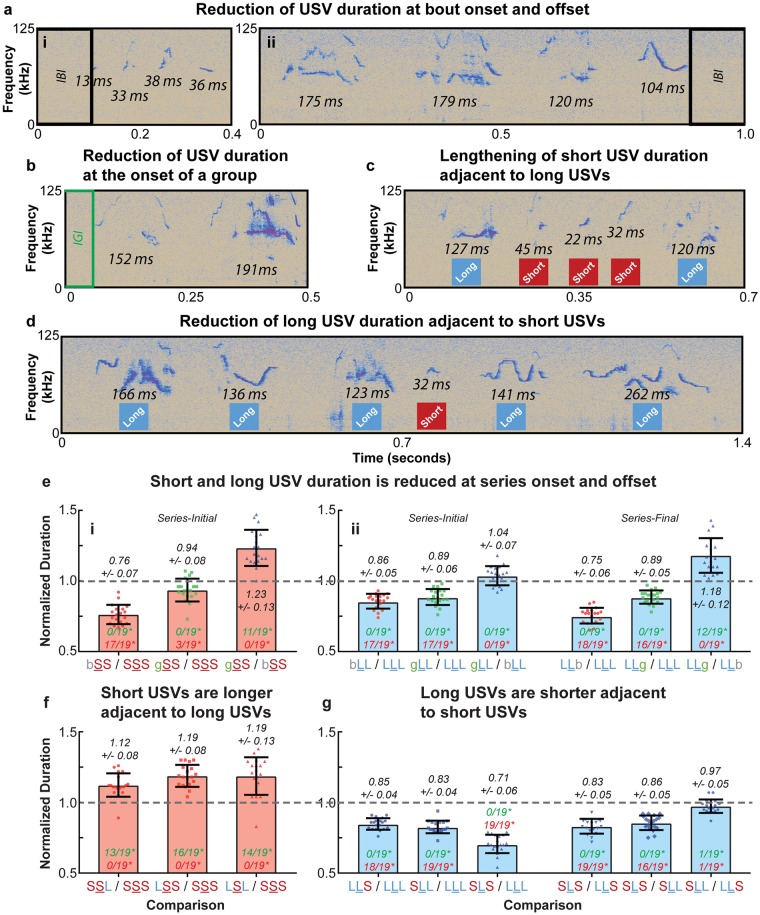
USV series exhibit consistent fine-scale temporal structure.(a) Example spectrogram from an adult male mouse showing reduction of USV duration (a.i) bout-initially (a.ii) bout-finally. (b) Example spectrogram from an adult mouse depicting reduction of long USV duration group-initially. Example spectrograms of USVs produced by an adult mouse demonstrating (c) the reduction of long USV duration adjacent to a short USV, and (d) the lengthening of short USV duration adjacent to long USVs. (e.i) Average normalized durations of short USVs at series onset across all 19 mice. Short USVs were significantly shorter at bout onset in a majority of mice, but not group onset (see S14 and S15 Tables for statistical details). (e.ii) Average normalized durations of long USVs series-initially (left) and series-finally (right). In most mice, long USVs were significantly shorter at the onset and offset of both groups and bouts, and were significantly shorter at bout offset compared to group offset (see S14 and S16 Tables for statistical details). (f) Average normalized durations of short USVs adjacent to long USVs across all 19 adult mice. In a majority of mice, short USVs were significantly longer when adjacent to long USVs. See S18 and S19 Tables for statistical details. (g) Average normalized durations of long USVs adjacent to short USVs across all adult 19 mice. In all environments examined, long USVs were significantly shorter when adjacent to short USVs in nearly all mice. See S18 and S20 Tables for statistical details. In (e-g), “b”, “g”, “S”, and “L” correspond to IBIs, IGIs, short USVs, and long USVs, respectively. Values on the plots are represented as normalized durations between the two trigrams listed on the x-axis. For example “bSS/SSS” indicates the mean duration of bout-initial short USVs (S) preceding a short USV normalized to the mean duration of short USV (S) flanked by short USVs. Error bars indicate the mean across animals +/-1 standard deviation, and values for individual mice are represented by the 19 overlaid points. The number of mice showing a significant reduction or lengthening of USV duration for each comparison is written in red and green, respectively. Summary statistics for (e) and (f-g) are presented in S17 and S21 Tables, respectively.